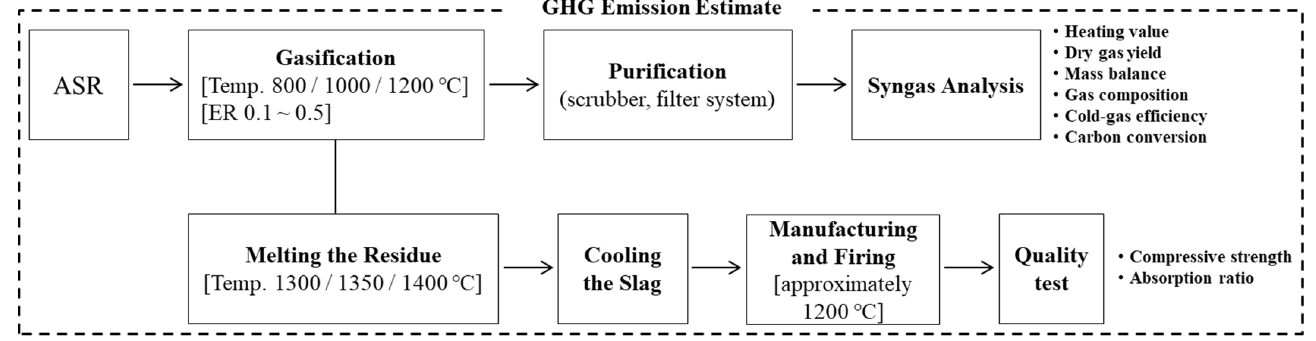
6 of 17 Table 6. Test methods and Instrument Specifications. Analysis Items